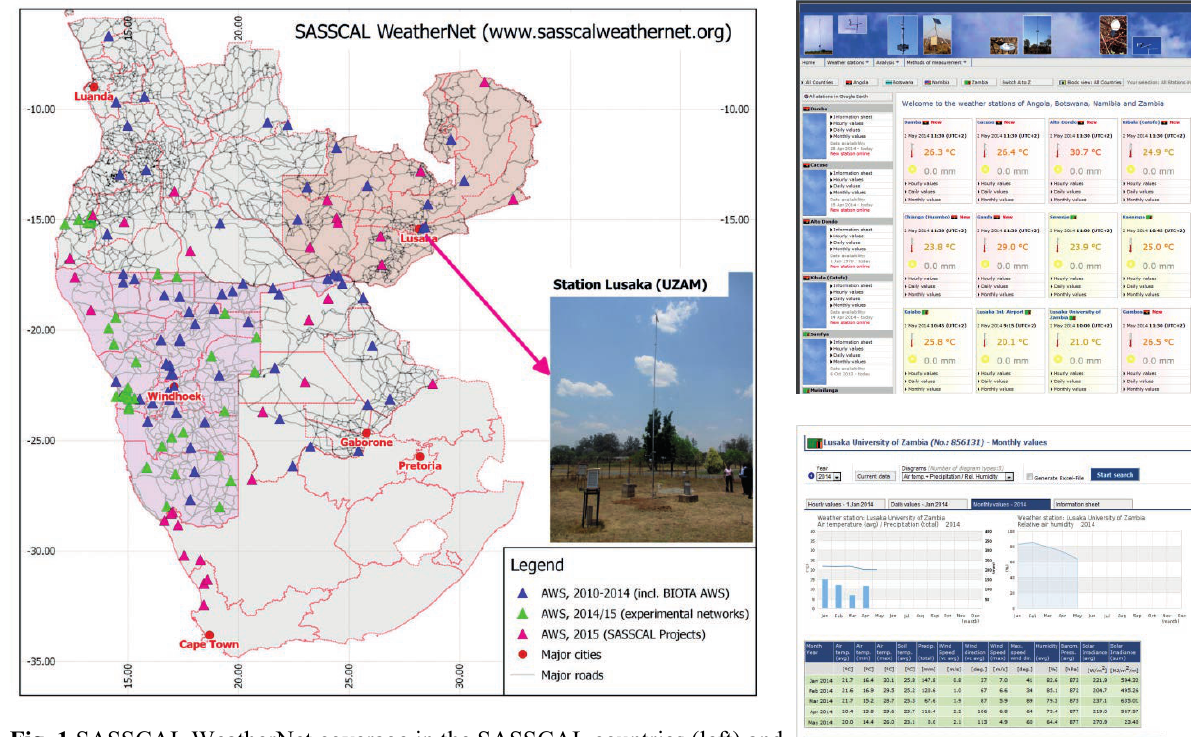
Fig. 1 SASSCAL WeatherNet coverage in the SASSCAL countries (left) and snapshots from the SASSCAL WeatherNet website (right). Note: A local network of five stations set up in the Notwane basin, Botswana, is not yet shown in the